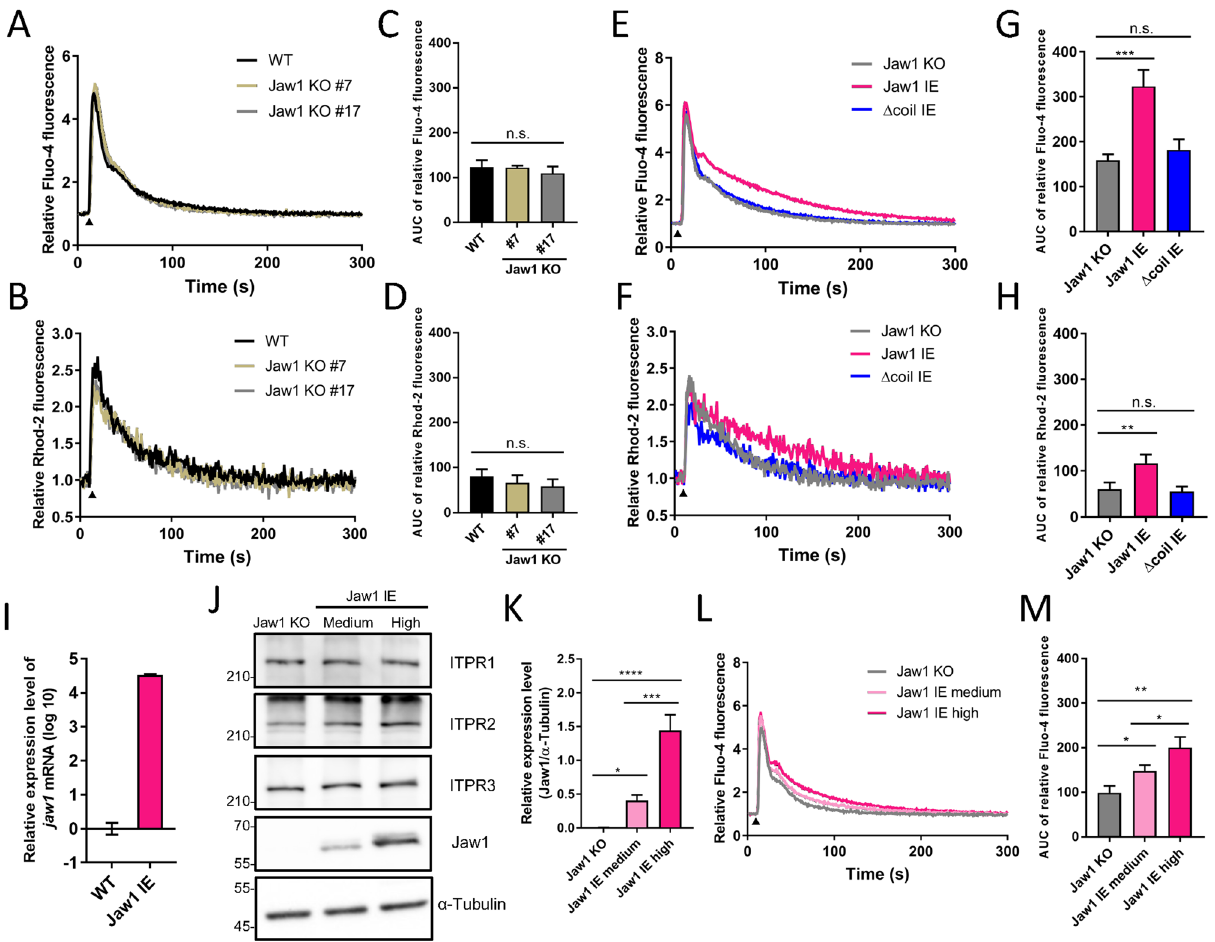
Figure 1. Jaw1 increases the Ca 2+ influx depending on its own expression level. ( A , B , E , F , L ) Mean curves of relative Fluo-4 ( A , E , L ) or Rhod-2 ( B , F ) intensity upon 100 µM ATP stimulation measured using a plate reader. WT, Jaw1 KO #7, and Jaw1 KO #17 cells ( A , B ); Jaw1 KO, Jaw1 IE, and Δcoil IE cells ( E , F ); or Jaw1 KO, Jaw1 IE medium, and Jaw1 IE high cells ( L ). The closed triangles indicate the time point of 100 µM ATP solution supplementation. ( C , D , G , H , M ) AUC in ( A ), ( B ), ( E ), ( F ), and ( L ) are shown in ( C ), ( D ), ( G ), ( H ), and ( M ), respectively. n = 3. ( I ) Relative expression level of jaw1 mRNA to gapdh in WT and Jaw1 IE cells measured by RT-qPCR. N = 3. ( J ) Jaw1 KO and Jaw1 IE cells treated with 0.25 or 200 ng/mL of Dox and subjected to western blotting. Images used for western blots are shown in Supplementary Fig. S4 online. ( K ) The relative protein expression level of Jaw1 with α-Tubulin in ( J ). n = 3. The error bar shows ± S.D.; n.s., non-significant; * p <